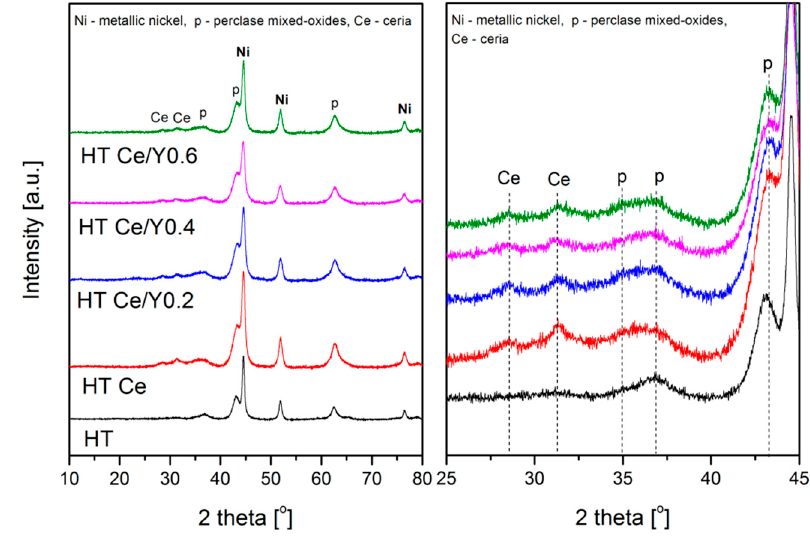
Figure 3. XRD diffractograms of the prepared catalysts after reduction in the mixture 5 vol.% of H 2 /Ar. Table 2. Texture, reducibility and Ni dispersion and Ni crystallite sizes for the studied materials after reduction in a mixture of 5 vol.% H 2 /Ar.